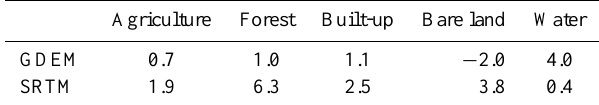
Table 4. The mean errors of GDEM and SRTM according to the land cover map. Unit: m. Agriculture Forest Built-up Bare land